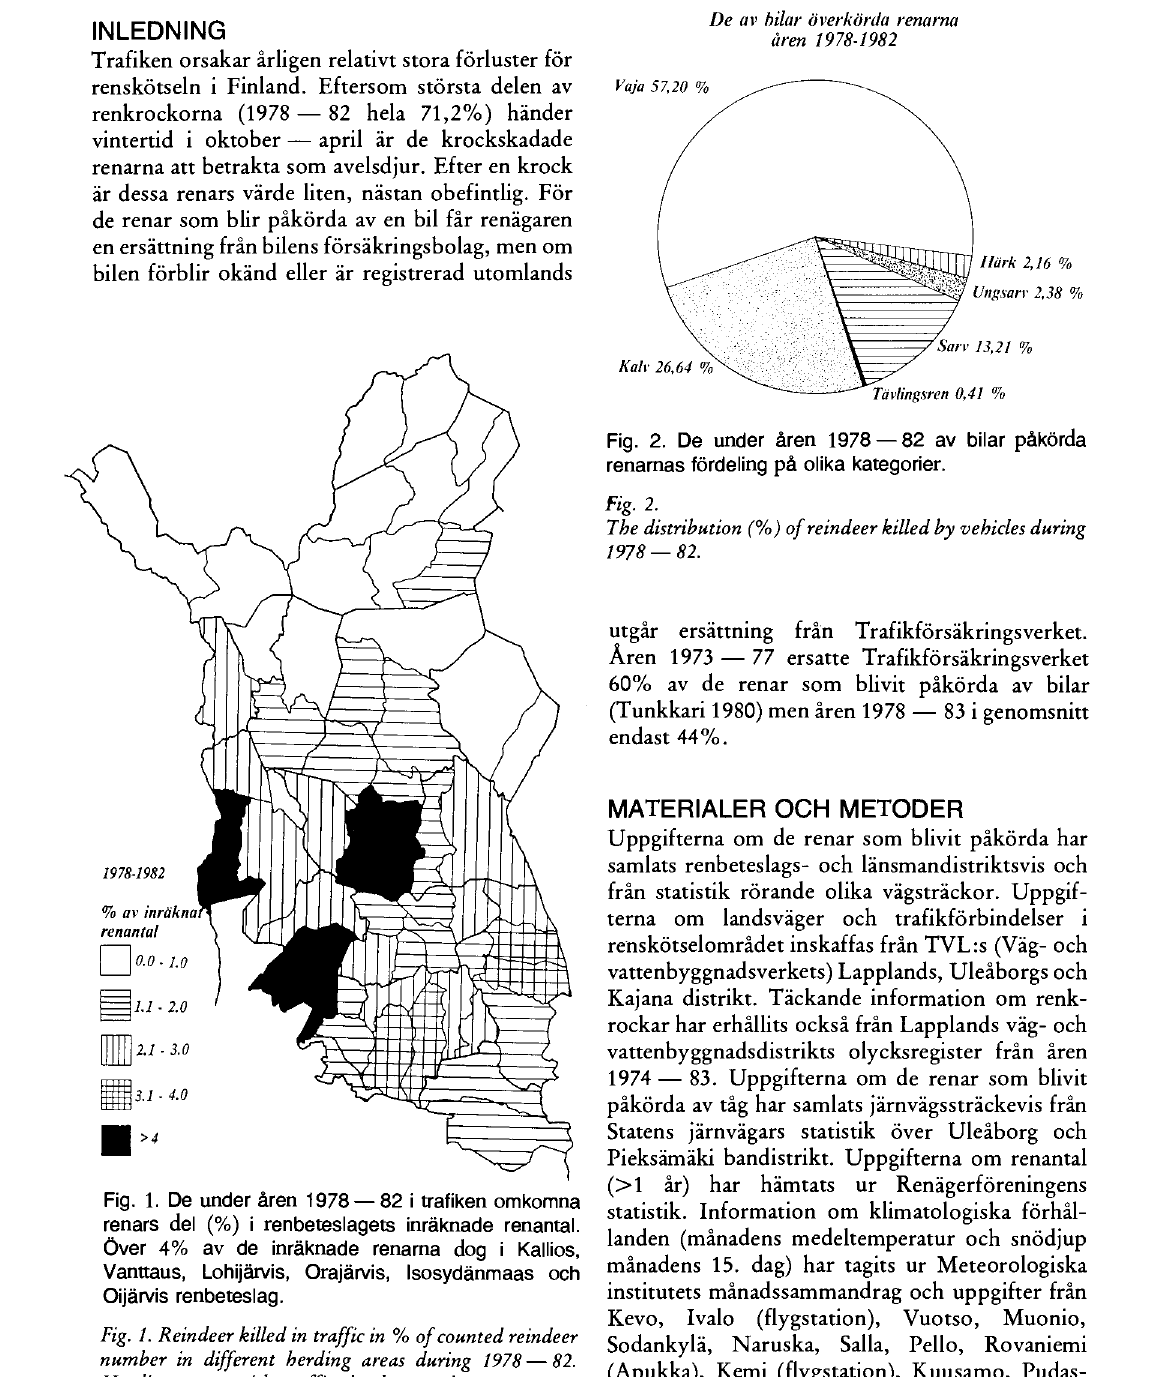
Fig. 1. De under åren 1978 — 82 i trafiken omkomna renars del (%) i renbeteslagets inräknade renantal. Över 4% av de inräknade renarna dog i Kallios, Vanttaus, Lohijärvis, Orajärvis, Isosydänmaas och Oijärvis renbeteslag. Fig. 1. Reindeer killed in traffic in % of counted reindeer number in different herding areas during 1978 — 82. Herding areas with traffic deaths exeeding 4% were: Kallio, Vanttaus, Lohijarvi, Orajarvi, Isosyddnmaa and Oijarvi.